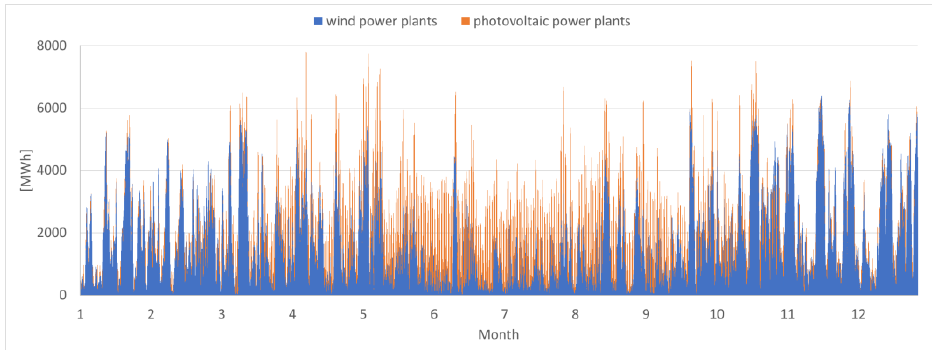
Figure 4. Energy generation by photovoltaic and wind power plants in Poland in 2021 (own compi- lation of data from PSE S.A.).